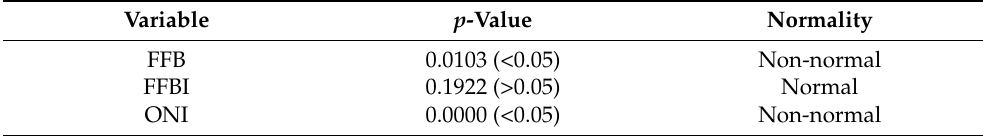
Table 4. Shapiro-Wilk normality test results for FFB, FFBI and